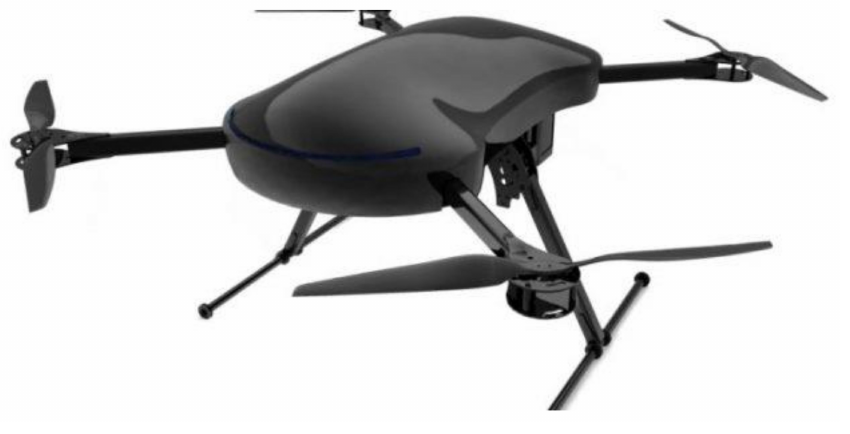
Figure 7. Hydrogen-powered UAV